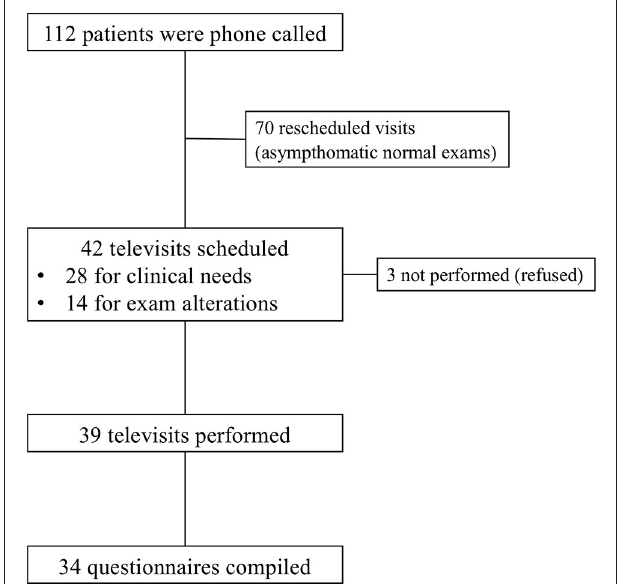
FIGURE 1 | Flowchart of the